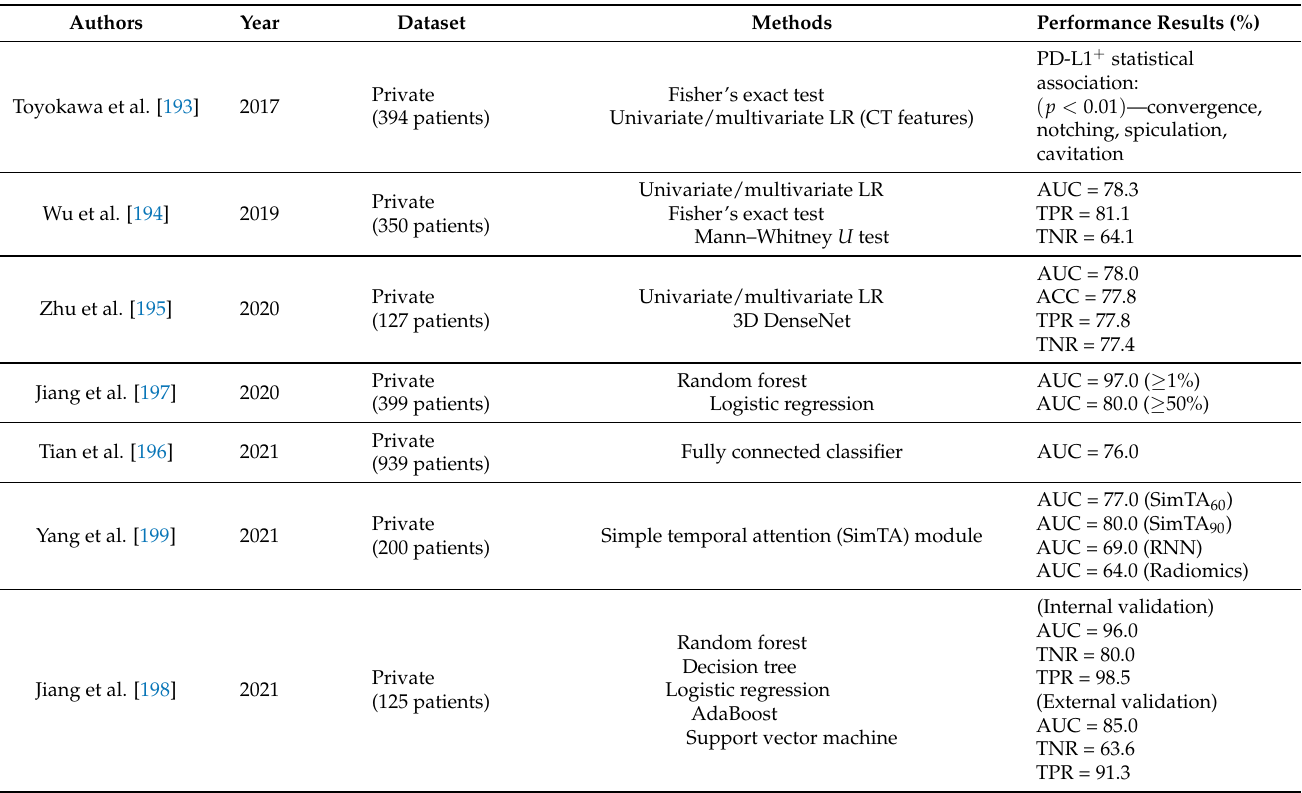
Table 8. Overview of published works regarding the prediction of PD-L1 expression status in lung cancer CT images